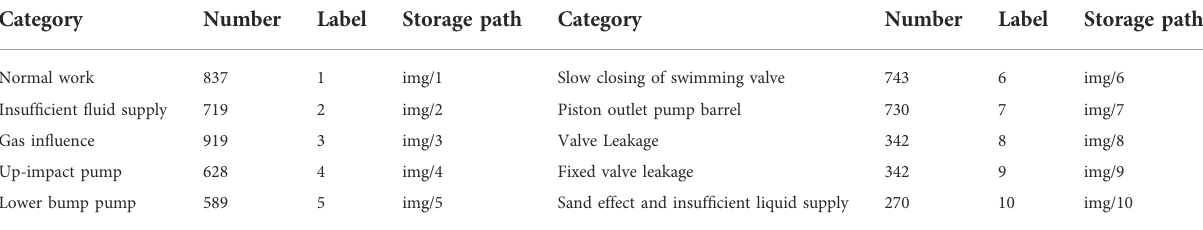
TABLE 5 Classi fi cation of indicator